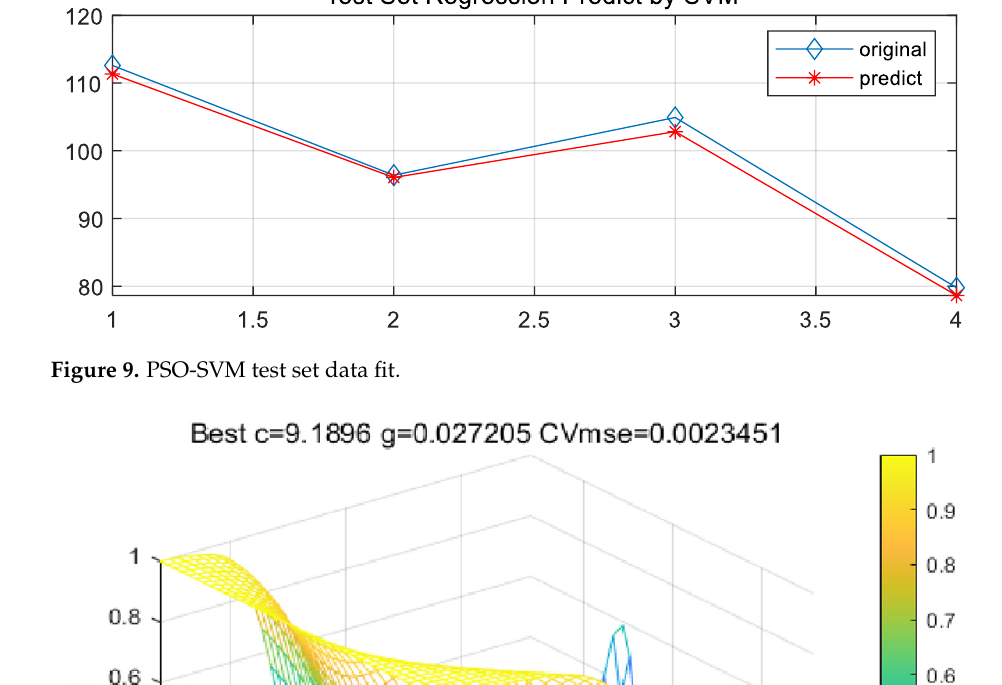
Figure 8. Particle swarm optimization parameter optimization fitness curve.